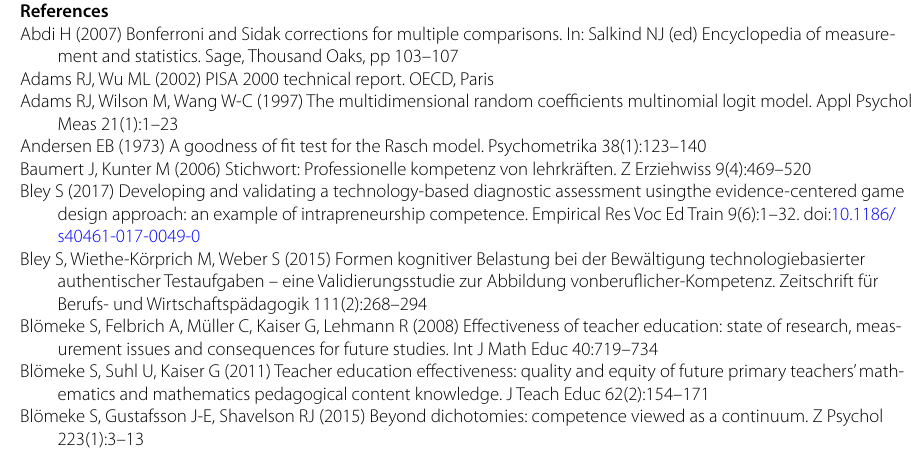
wMNSQ weighted mean square, CI confidence